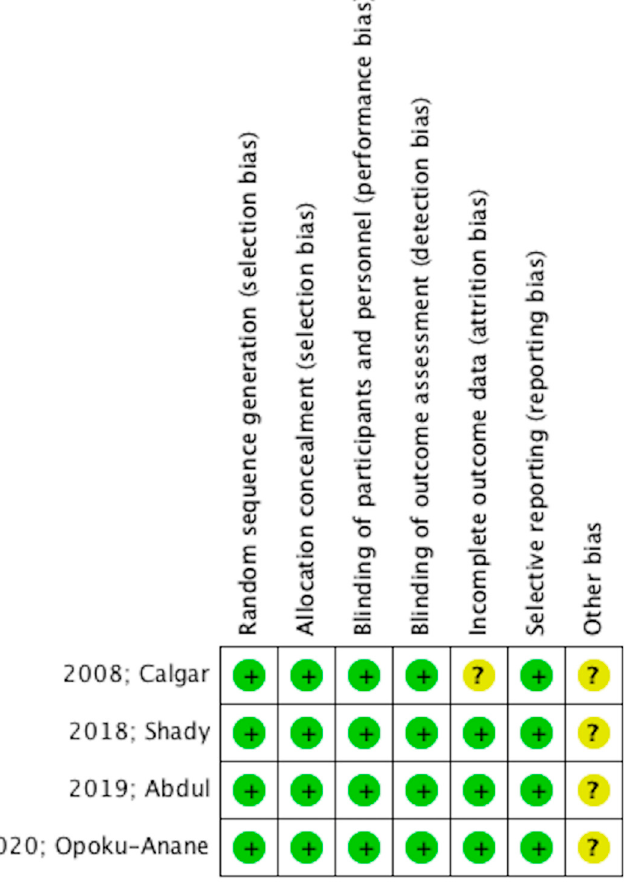
Figure 2. RCT methodological quality. Risk-of-bias summary: “?” represents unclear bias, and “+” represents low risk of bias [13–16].